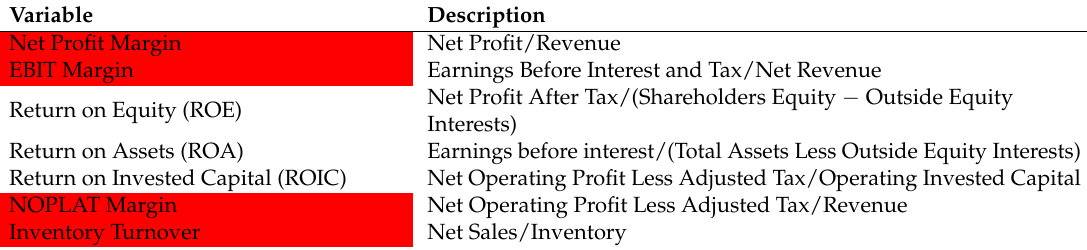
Table 2. Complete list of variables —variables highlighted in red were later omitted due to missing